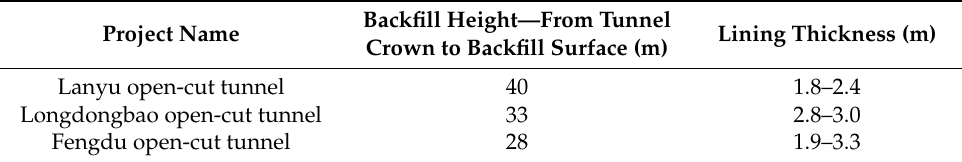
Figure 1. Open-cut tunnel built in a valley close to a city. Table 1. Details of three existing open-cut tunnels in China.